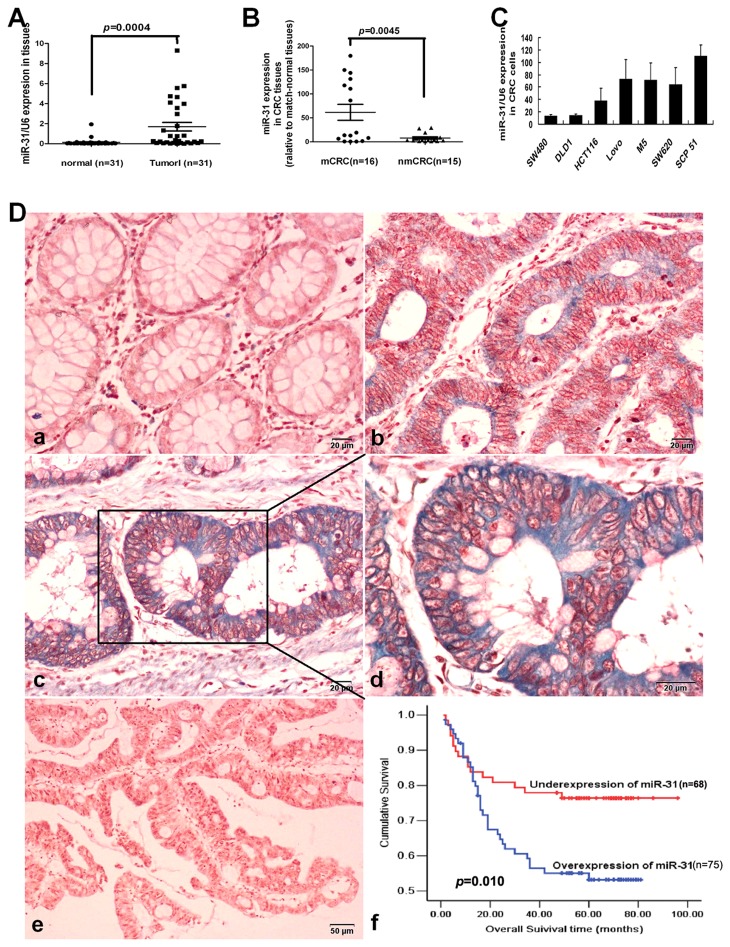
The levels of miR-31 expression in CRC cells and tissues by qRT-PCR or in
situ hybridization and its prognostic value in patients with CRC.(A) Expression levels of mature miR-31 in paired CRC and adjacent normal tissues. (B) The miR-31 expression in CRC tissues with or without metastases relative to match-normal tissues. nmCRC denotes CRC tissues without metastases; mCRC denotes CRC tissues with lymph node metastases. (C) Expression of miR-31 in CRC cell lines and subclones. miRNA abundance was normalized to U6 RNA. (D) Expression analysis of miR-31 in normal colorectal mucosa and CRC tissues by in
situ hybridization. (a) Negative expression of miR-31 in normal colorectal mucosa; (b) Low expression of miR-31 in CRC tissues; (c, d) High expression of miR-31 in CRC tissues; (e) negative control; (f) Kaplan-Meier analysis for survival of patients with CRC according to miR-31 expression. Log Rank = 6.682, p = 0.010.